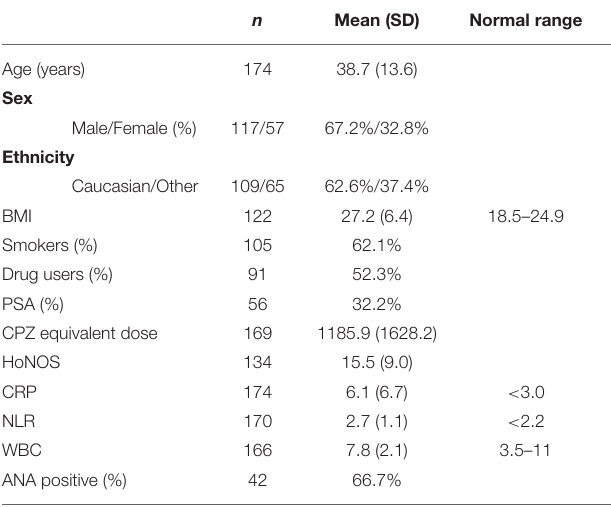
TABLE 3 | Demographics, clinical and inflammation measures in the acute psychosis